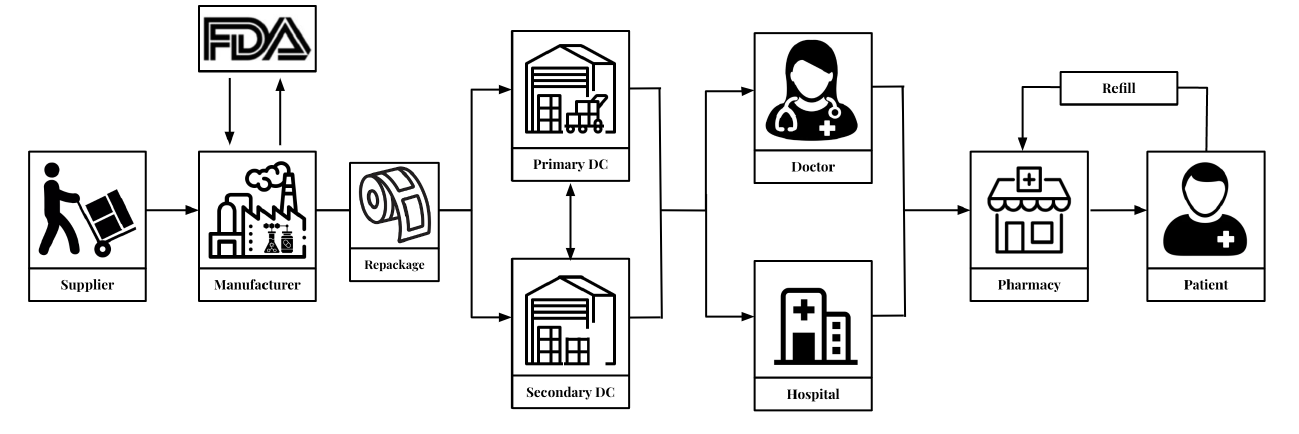
Figure 1. Pharmaceutical supply